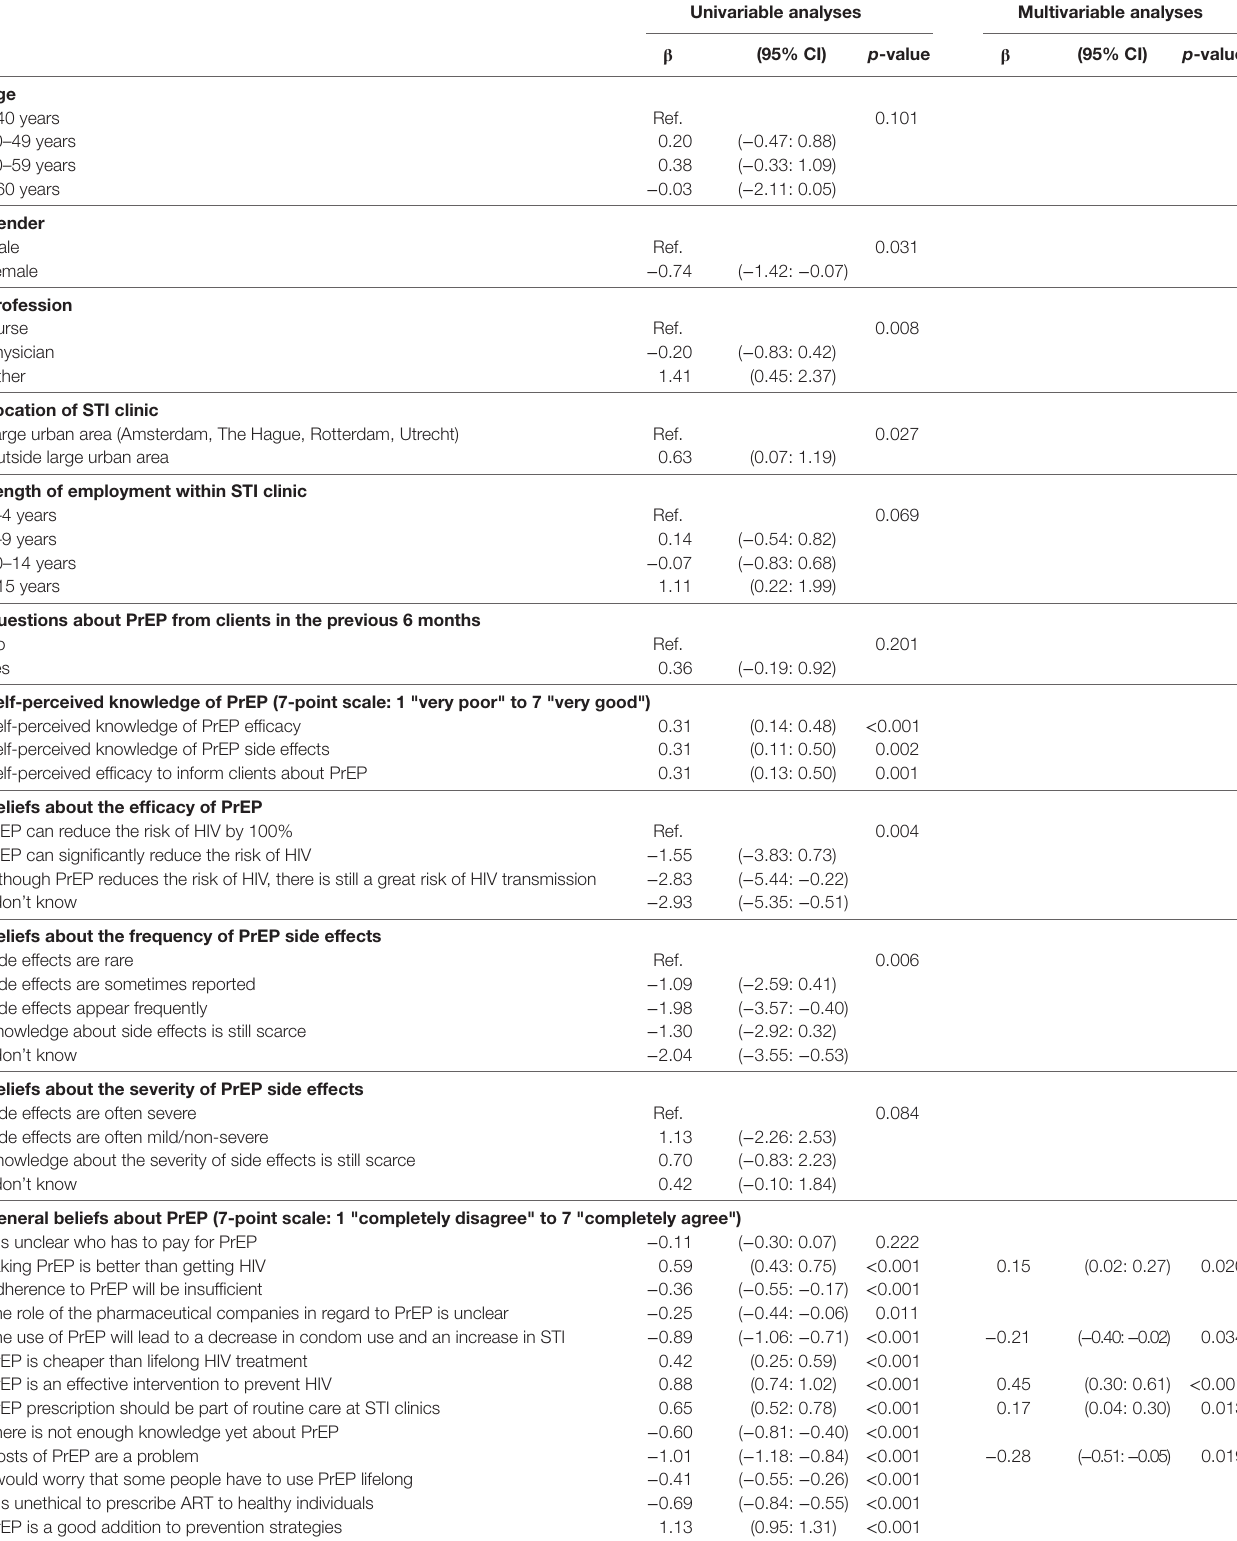
TaBle 3 | Determinants of acceptability of PrEP implementation in the Netherlands among 143 STI professionals in the Netherlands